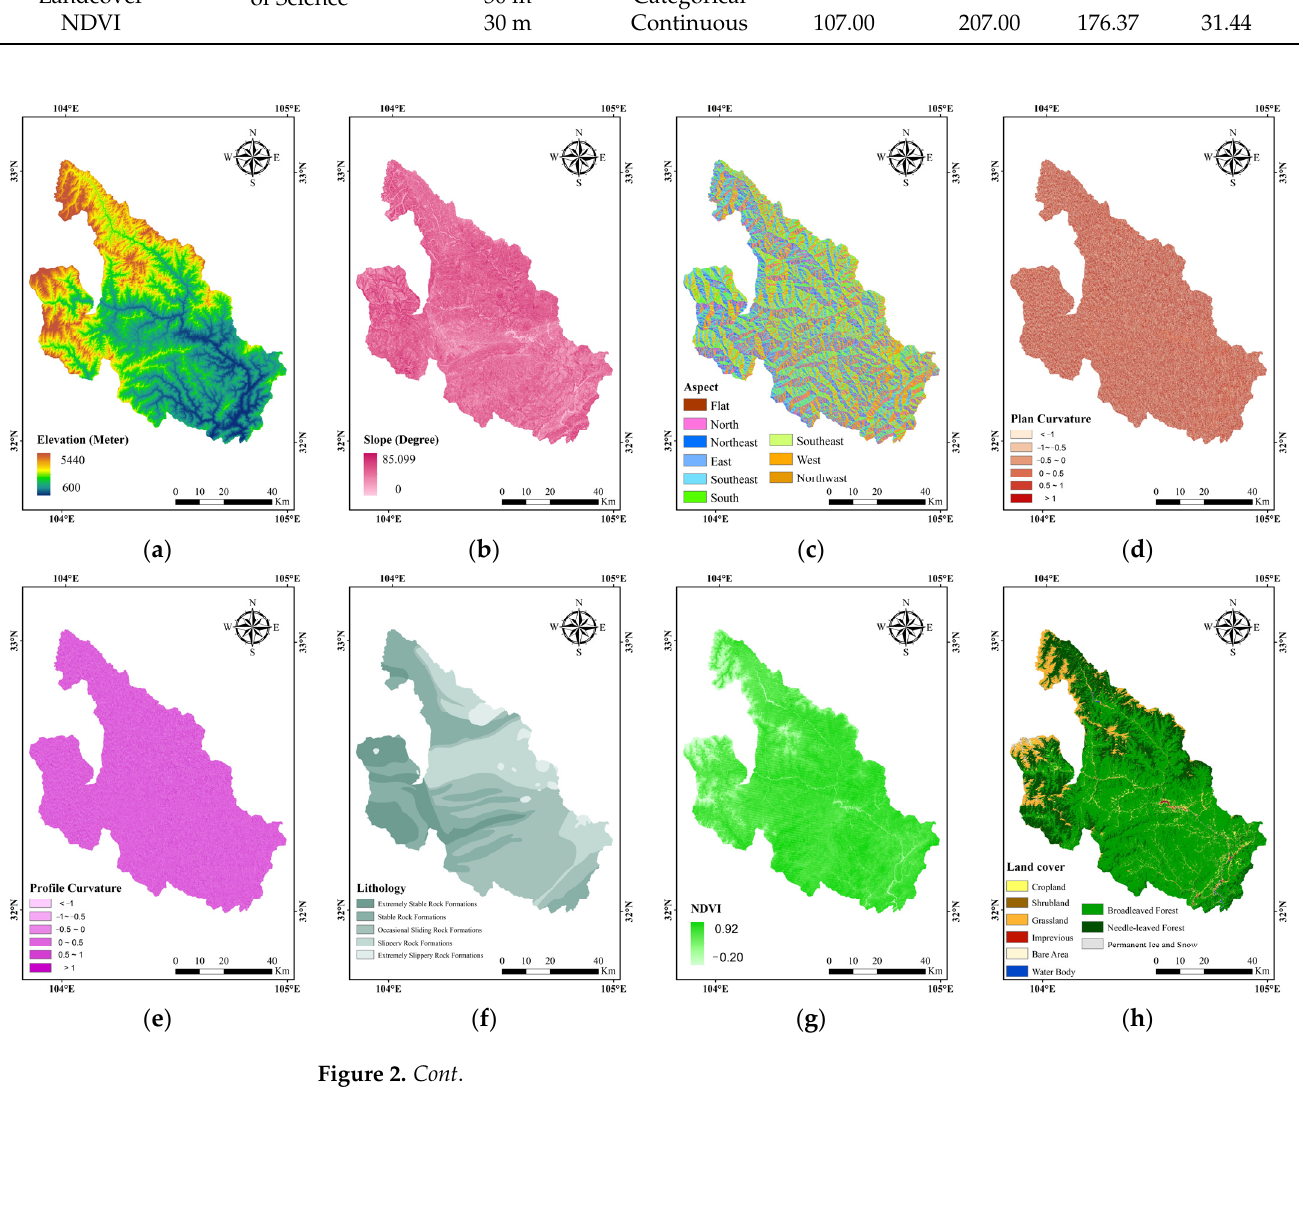
( k ) Figure 2. Landslide conditioning factors of LSM. ( a ) Elevation, ( b ) Slope, ( c ) Aspect, ( d ) Plan curva- ture, ( e ) Profile curvature, ( f ) Lithology, ( g ) NDVI, ( h ) Landcover, ( i ) Rainfall, ( j ) Distance to river and ( k ) Distance to fault.